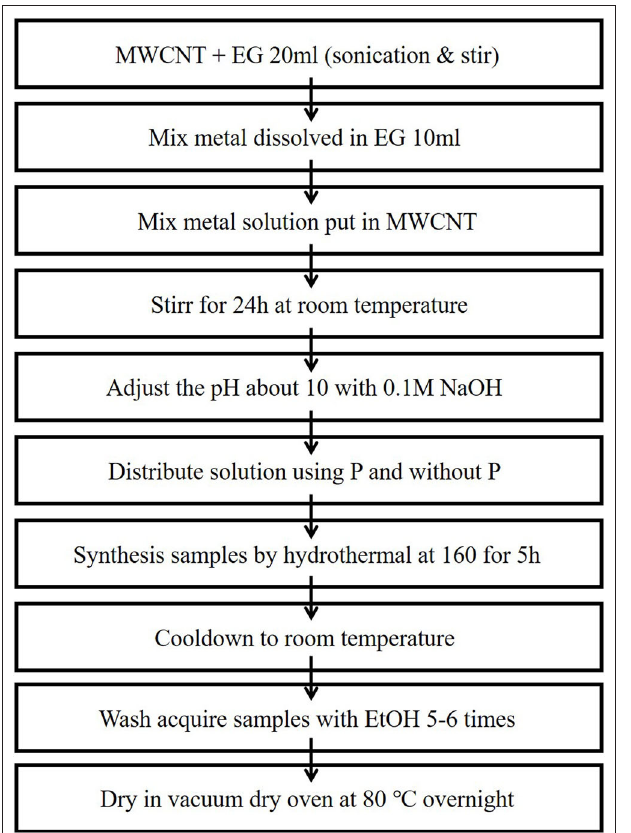
FIGURE 3 | XRD profiles of Ni-Pd/MWCNT and Ni-Pd(P)/MWCNT